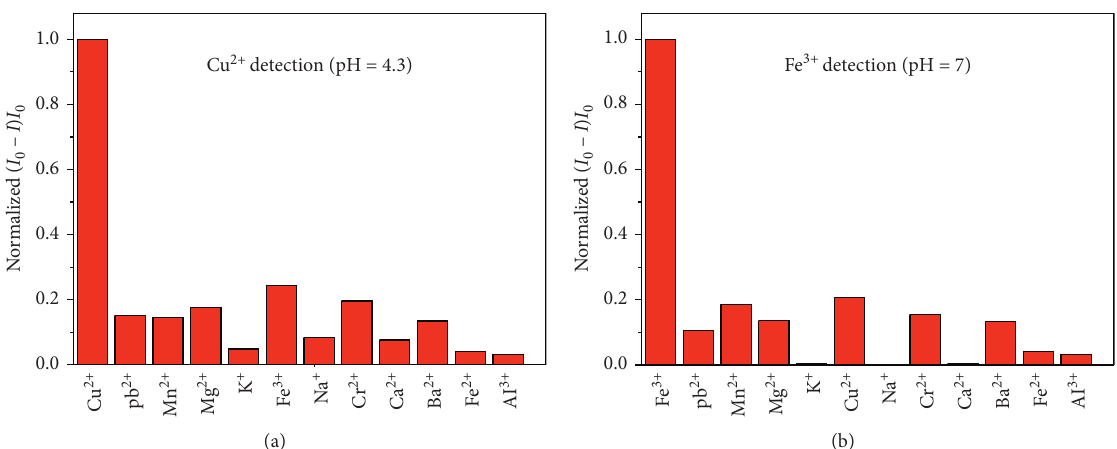
Figure 4: Selectivity patterns of the Ag NCs to Cu 2+ at pH � 4.3 (a) and Fe 3+ at pH � 7 (b). All metal ions concentrations were 100 μ